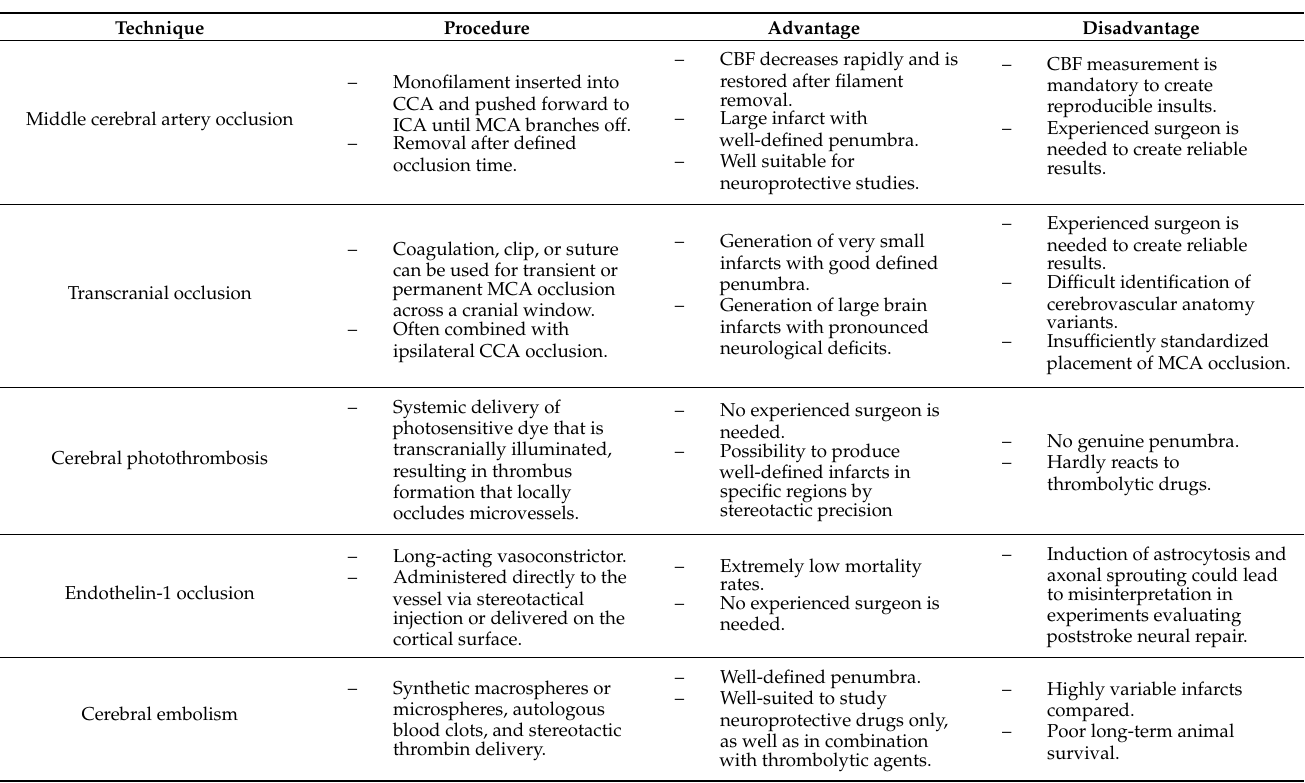
Table 1. Overview of occlusion techniques in ischemic stroke